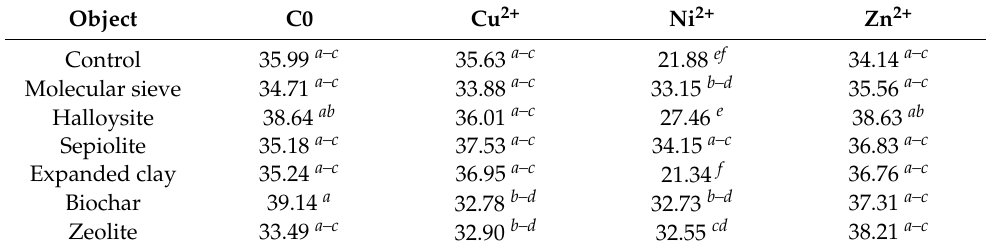
Table 5. Greenness index (SPAD) of Helianthus annuus L.